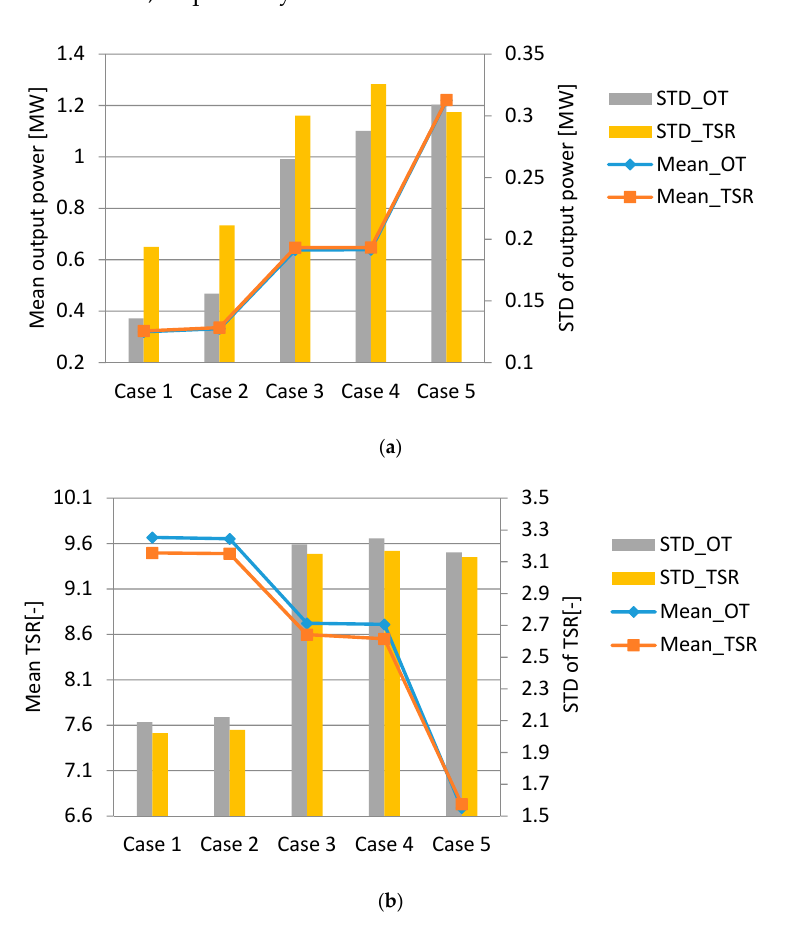
Figure 10. Statistical results comparison for the two controllers under four cases: ( a ) the output power results; and ( b ) the TSR results.